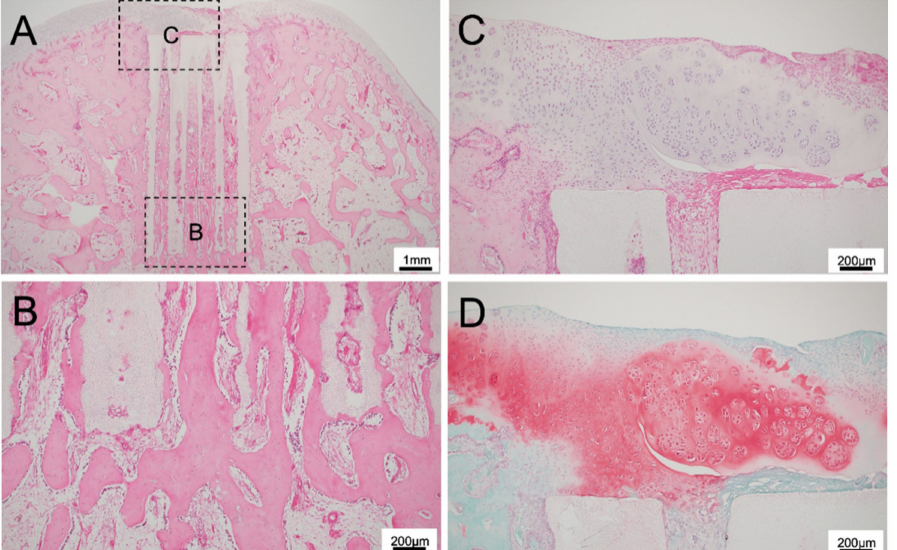
Figure 5. ( A ) Histological finding of 300TCP with TGF- β +BMP without Matrigel at low power magnification. ( B – D ) Histological finding of 300TCP with TGF- β +BMP without Matrigel at high power magnification. Bone formation from existing bone was observed in the area where the TCP was in contact with existing bone marrow. Cartilage regeneration was also observed, and spherical cartilage stained by Safranin O was also observed in the superficial layer of the TCP.